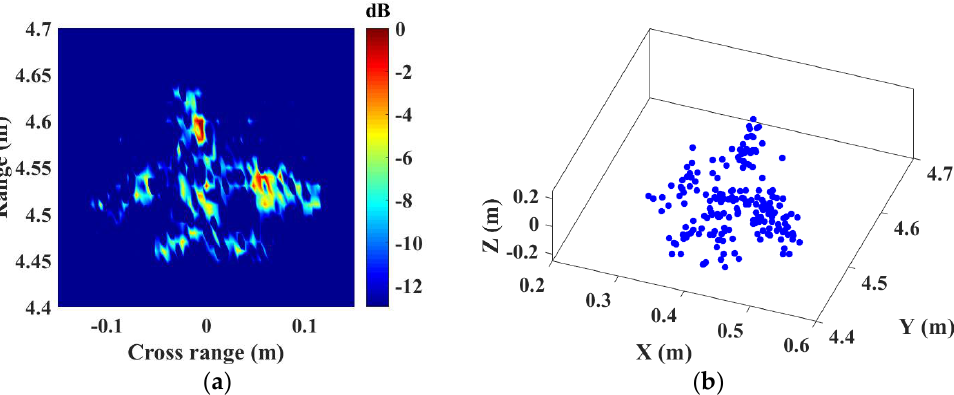
Figure 13. ISAR and InISAR imaging results of the moving target in the right window. ( a ) 2D ISAR image, ( b ) 3D InISAR image.